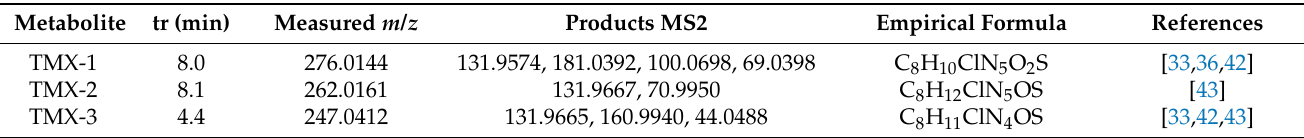
Figure 3. Proposed TMX biodegradation pathway by L. portucalensis strain F11. Table 3. TMX degradation metabolites detected by